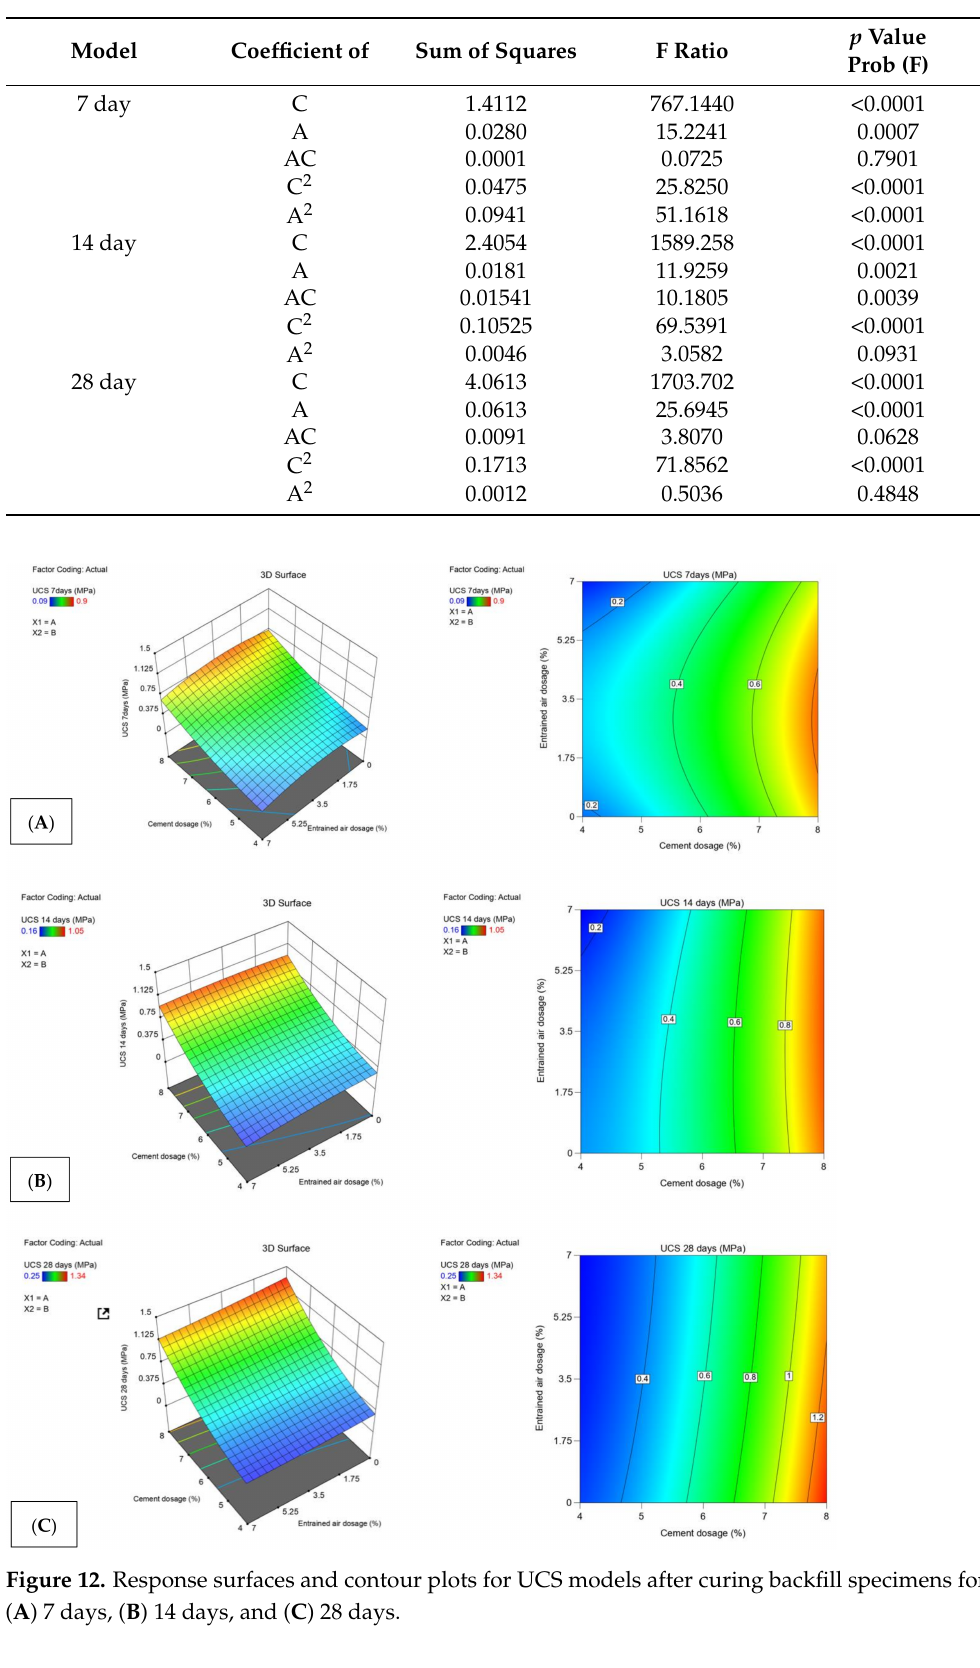
Table 9. ANOVA results for UCS regression coefficients of backfill specimens cured for 7, 14, and 28 days.